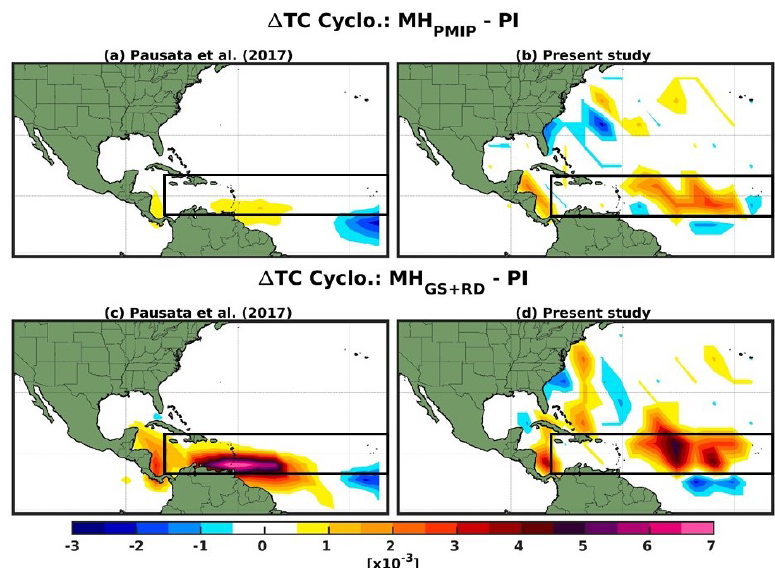
Figure A10. Comparison between TC seasonal cyclogenesis density anomalies for the (a, b) MH PMIP and (c, d) MH GS + RD experiments relative to PI between (a–c) Pausata et al. (2017) and (b–d) the present study. Note that data are represented over a 5 ◦ mesh-grid Mercator projection in the present study, while in Pausata et al. (2017) a 4 ◦ mesh grid is used to represent the fields. The black box shows the approximate present-day